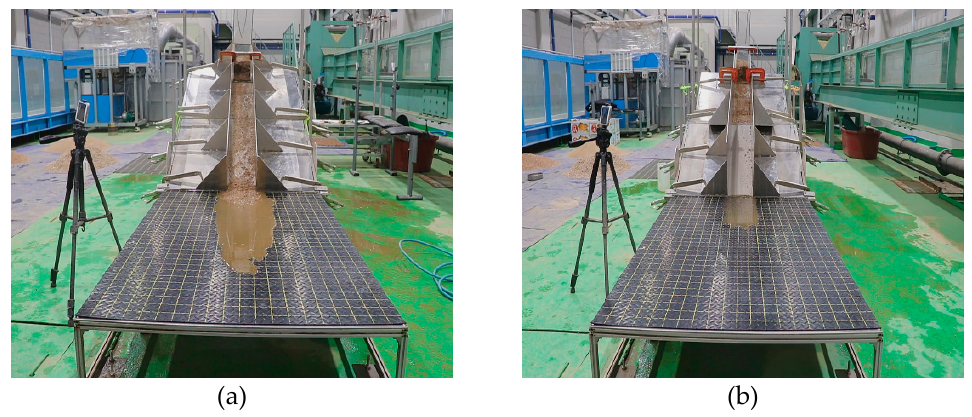
Figure 4. Examples of flume experiments conducted in this study: ( a ) Straight channel test ( α was 25° and C V was 0.50); and ( b ) single-berm channel test ( α was 25° and C V was 0.50).